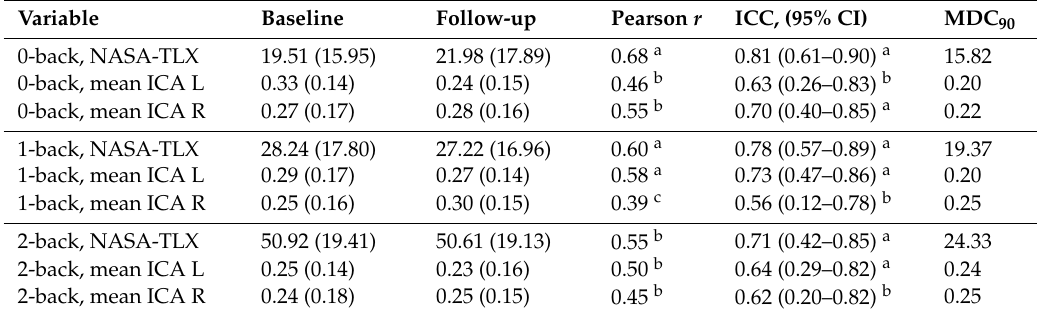
Table 1. Comparison of NASA-TLX and ICA at baseline and at a two-week follow-up ( n =